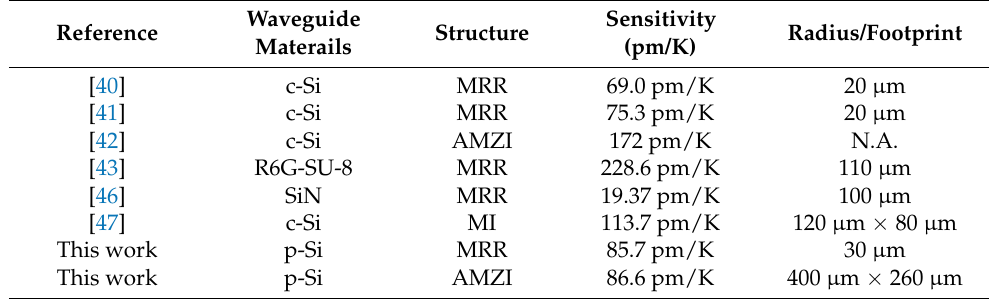
Table 1. Comparison of temperature